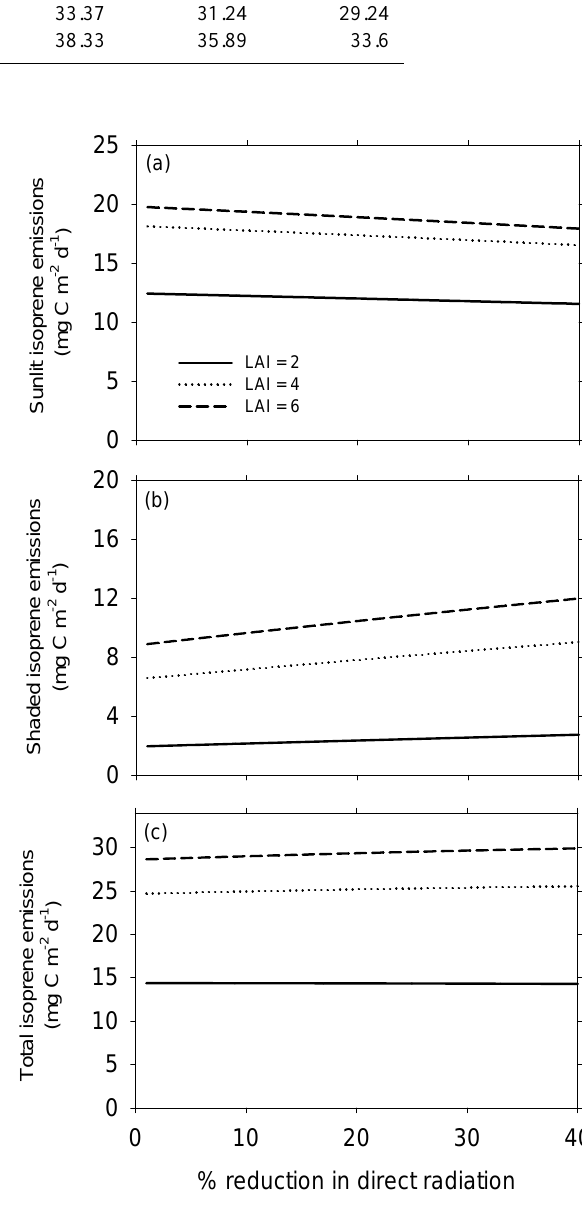
Fig. 4. Calculated daily variations in (a) sunlit, (b) shaded, and (c) total canopy isoprene emissions as the proportion of I dir decreases with a corresponding increase in I diff such that the total PAR re- mains constant for a particular hour. Results are shown for a range of leaf area indices (LAIs). All other conditions are as given in main